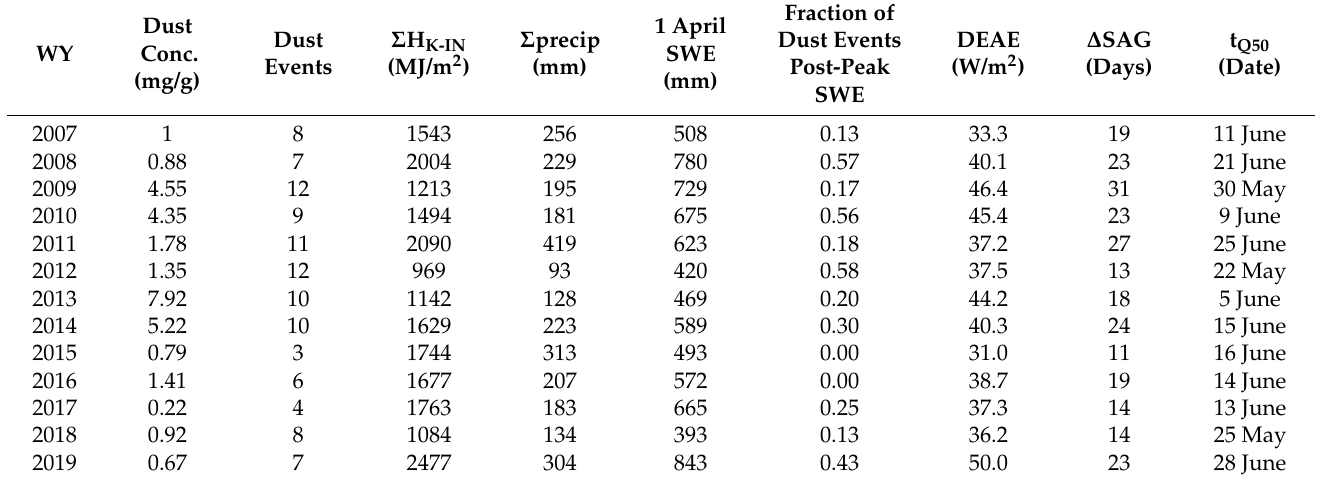
Table A3. Observed (dust concentration to dust events post-peak SWE in columns 2 to 7), computed (DEAE in column 8), SNOBAL modeled ( ∆ SAG in column 9), and streamflow-derived (t Q50 in column 10) annual data for the 13 study years at SBB, as per the data presented in Table